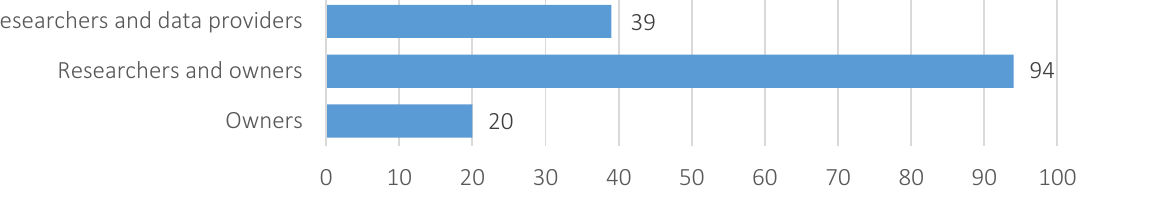
Figure 3. Structure of sustainability ratings issuers in 2017